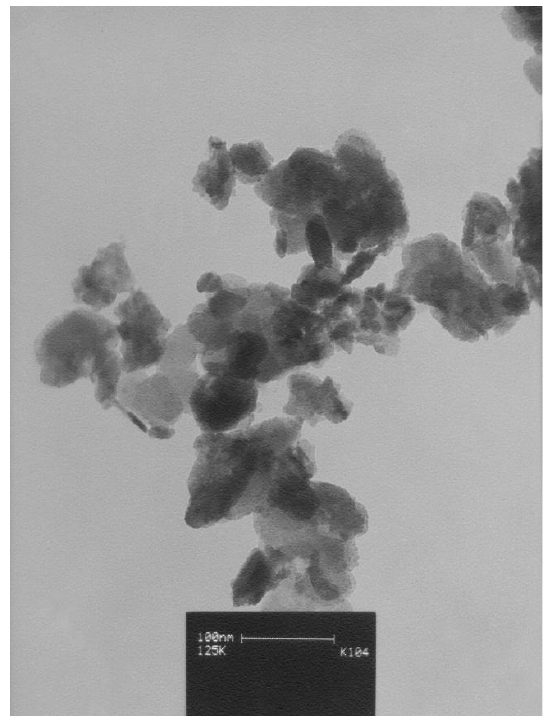
Fig. 3. TEM image of PbO milling, speed= 250 rpm and BPR=30.